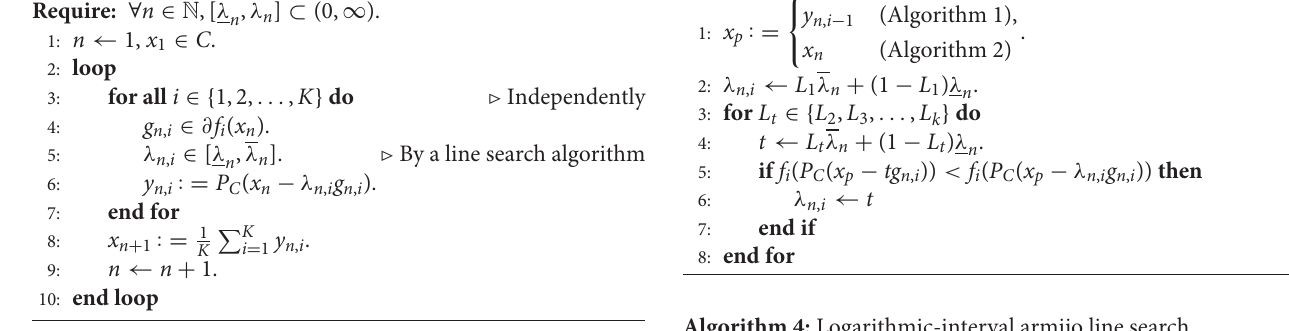
Algorithm 2 chooses a learning rate λ n from the step-range